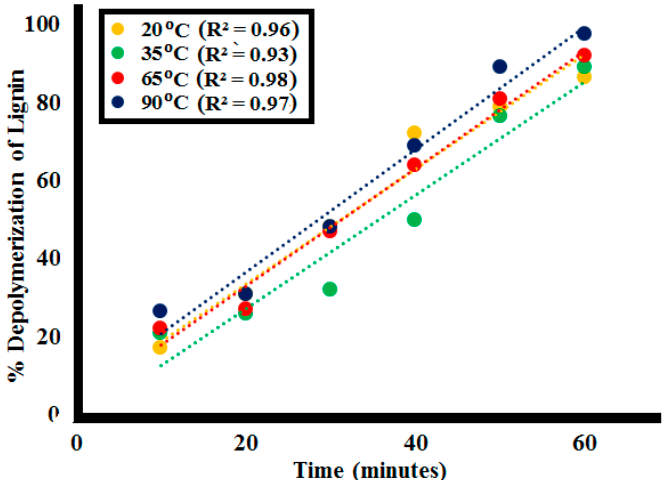
Figure 14. Correlation between %depolymerization of the lignin ( L1 100ppm ) by SK9 and different